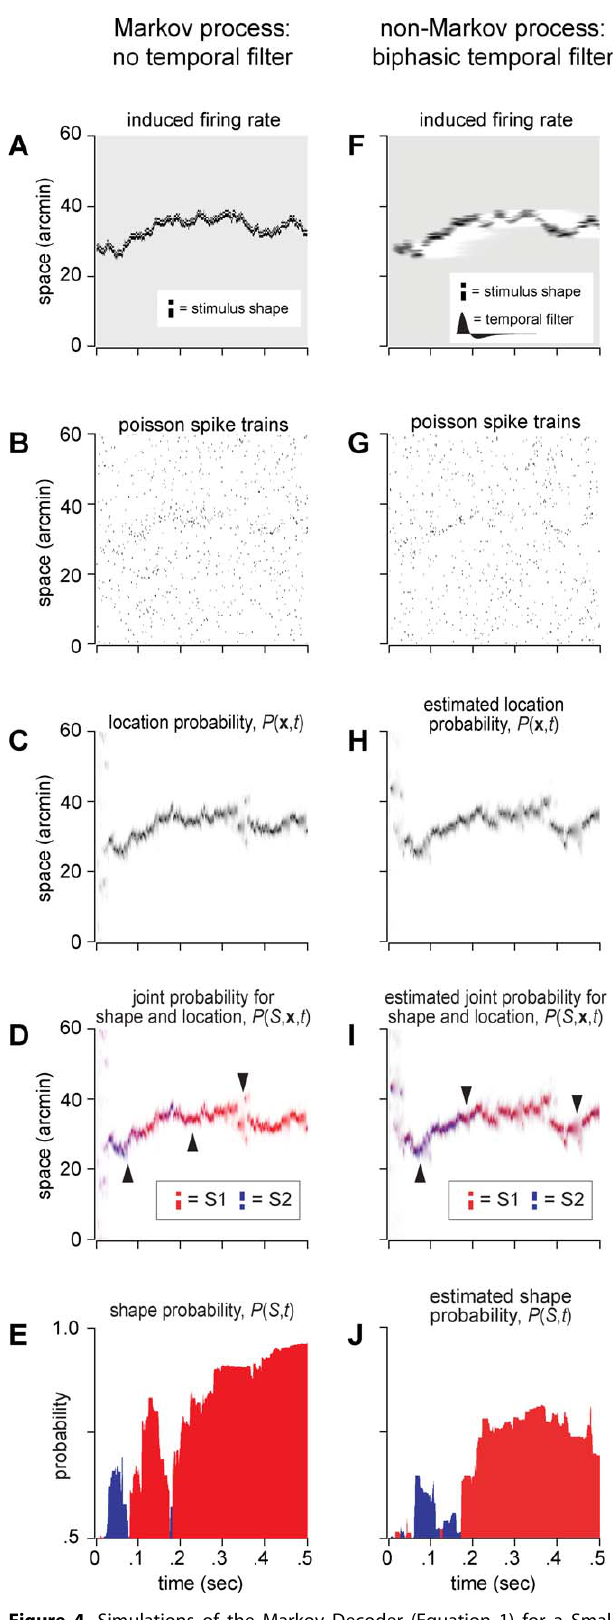
Figure 4. Simulations of the Markov Decoder (Equation 1) for a Small Stimulus Moving on a One-Dimensional Model